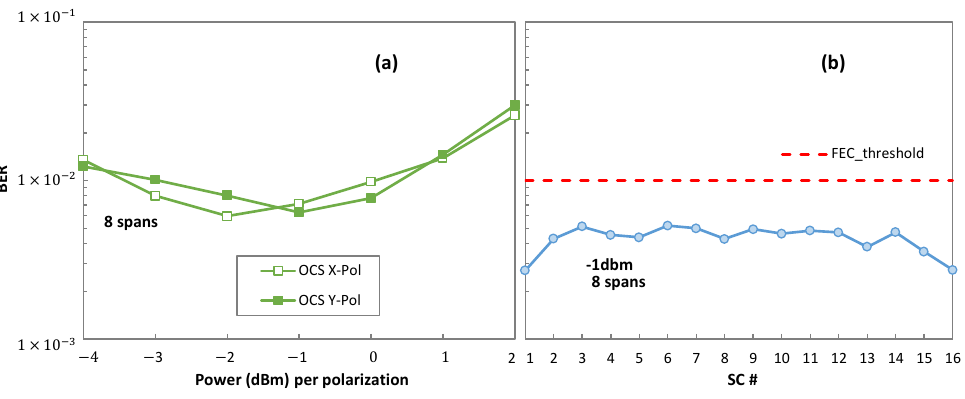
Figure 7. Optical system performance of OCS and DSCM for P2MP. Complementing Figure 7, Figure 8 details the optical performance of OCS for each individual polarization (Figure 8a) and the performance of each SC of the DSCM system (Figure 8b), considering for eight spans. The BER of both polarizations are almost the same in OCS. However, the performance of each SC at − 1 dbm reveals that the SCs in the center are affected more than the SCs at the extremes because of the SC interaction mainly due to the non-linearities. However, the BER remains under the FEC threshold, thus guaranteeing the same post-FEC performance of each SC.